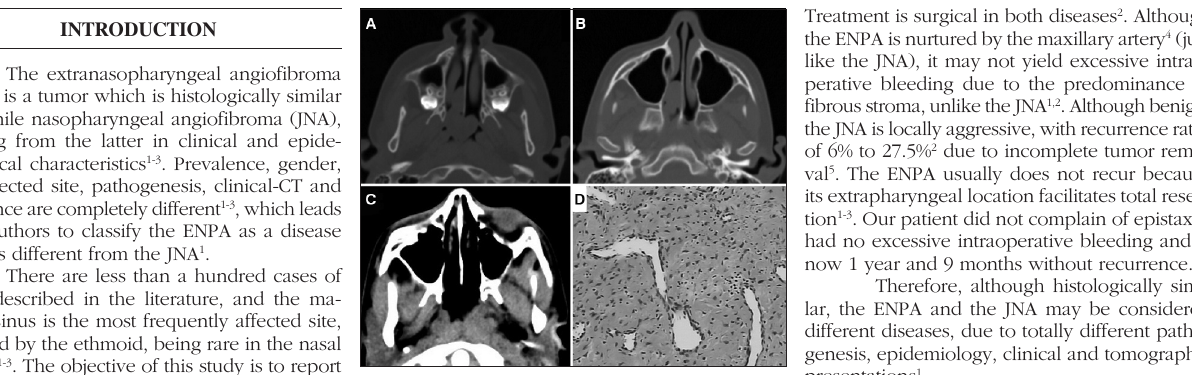
Figure 1. A: Preoperative axial CT scan showing the tumor inserted into the nasal septum and extending to the